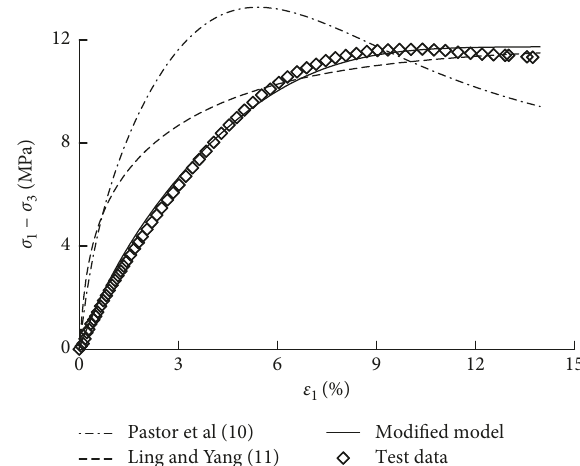
Figure 2: Comparison of the original model and model proposed by Ling et